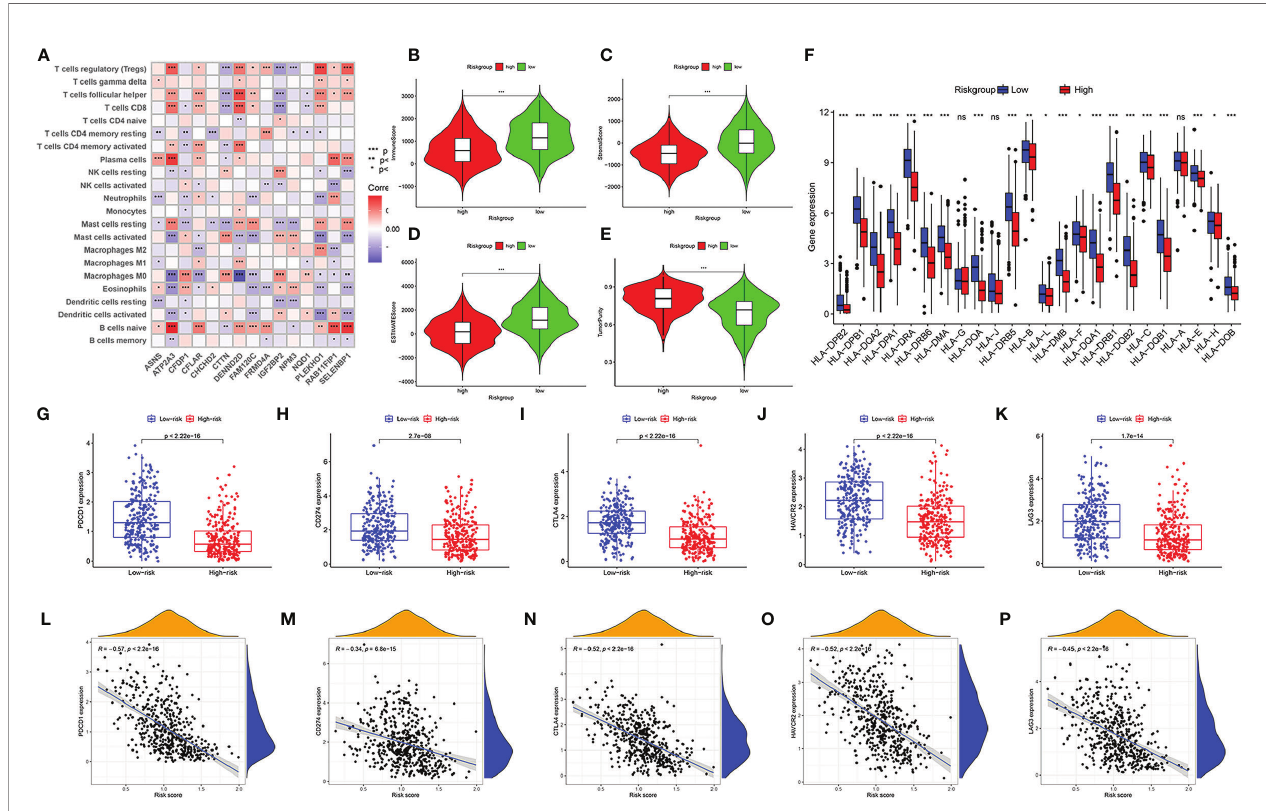
FIGURE 7 | Immune landscape of patients with head and neck squamous cell carcinoma (HNSCC) in high- and low-risk groups. Correlation matrix of 15 immune- related RNA-binding proteins (RBPs) and in fi ltrating immune cells (A) . Comparison of immune score (B) , stromal score (C) , ESTIMATE score (D) , and tumor purity (E) . The differential expressions of HLA family genes in patients with HNSCC in high- and low-risk groups (F) . The expression level of immune checkpoint genes PDCD1 (G) , CD274 (H) , CTLA4 (I) , HAVCR2 (J) , and LAG3 (K) in low-risk group and high-risk group. The correlation between risk score and immune checkpoints PDCD1 (L) , CD274 (M) , CTLA4 (N) , HAVCR2 (O) , and LAG3 (P) . “ ns ” means p ≥ 0.05, * p < 0.05, ** p < 0.01, *** p <